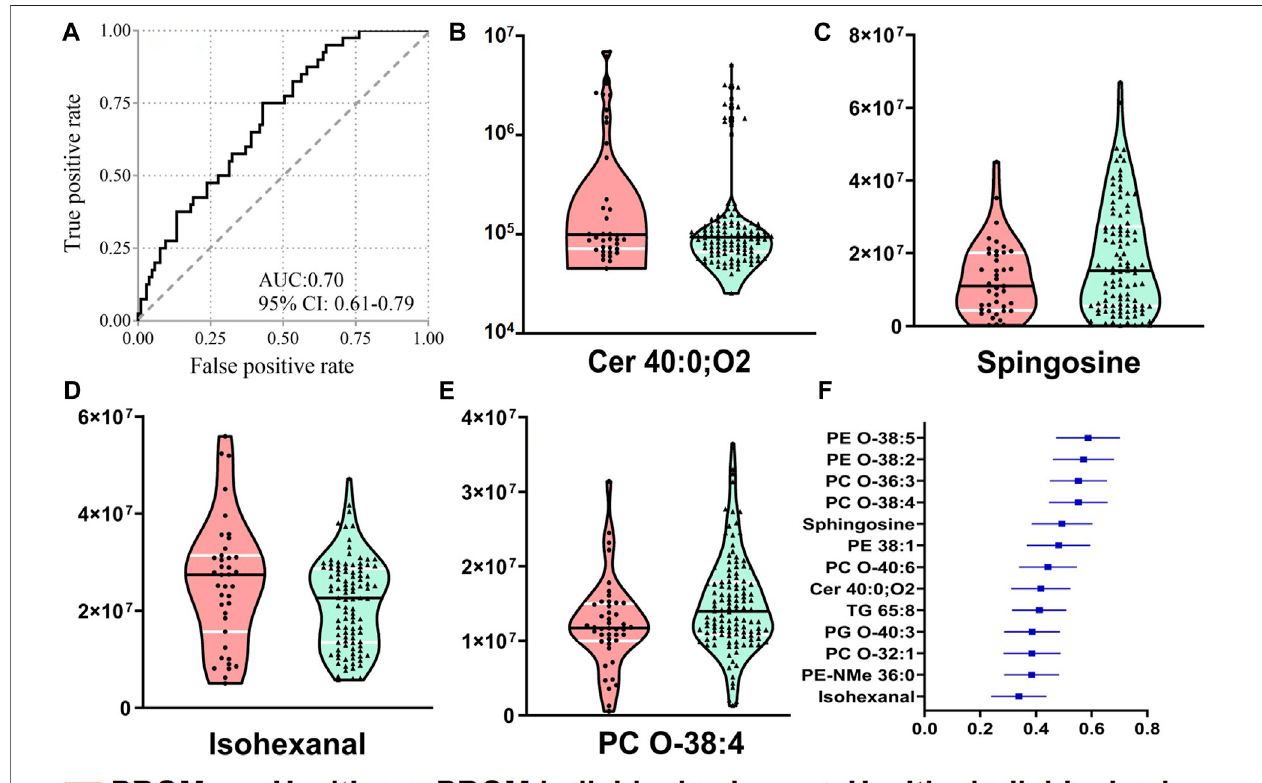
FIGURE5 | ThelogisticregressionmodelbasedonfourmetabolitesforpredictingPROMinearlypregnancyserumsamples. (A) TheROCcurveofthecombinationof four compoundsinserum.Violinplots(medianswithquartiles)areshownoffour compounds,Cer40:0;O 2 (B) ,sphingosine (C) , isohexanal(afattyaldehyde) (D) and PCO- 38:4 (a glycerophospholipid) (E) , with signi fi cant differences between the PROM and healthy cohorts. The forest plot of the AUC values of differential compounds (F) .